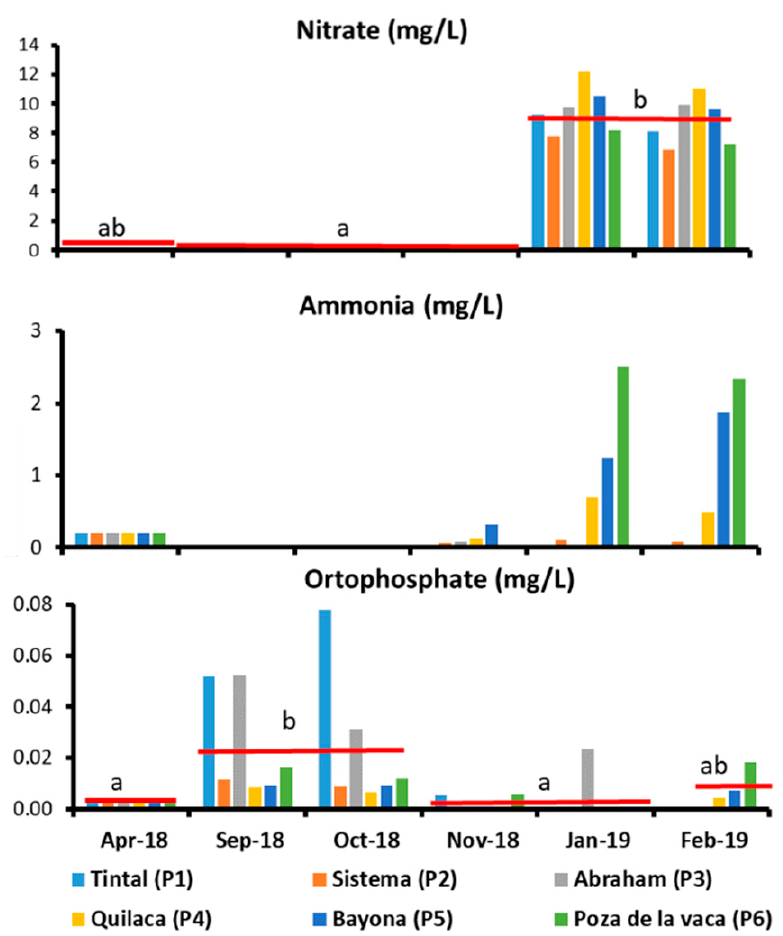
Figure 3. Nutrient concentrations measured in the six sites of the Estero del Padre Ramos. Red lines show the mean of each different group based on the ANOVA results (Table S2; Supplementary material). The lower-case letters indicate significant differences in pairwise comparisons. Significant values when p < 0.001.